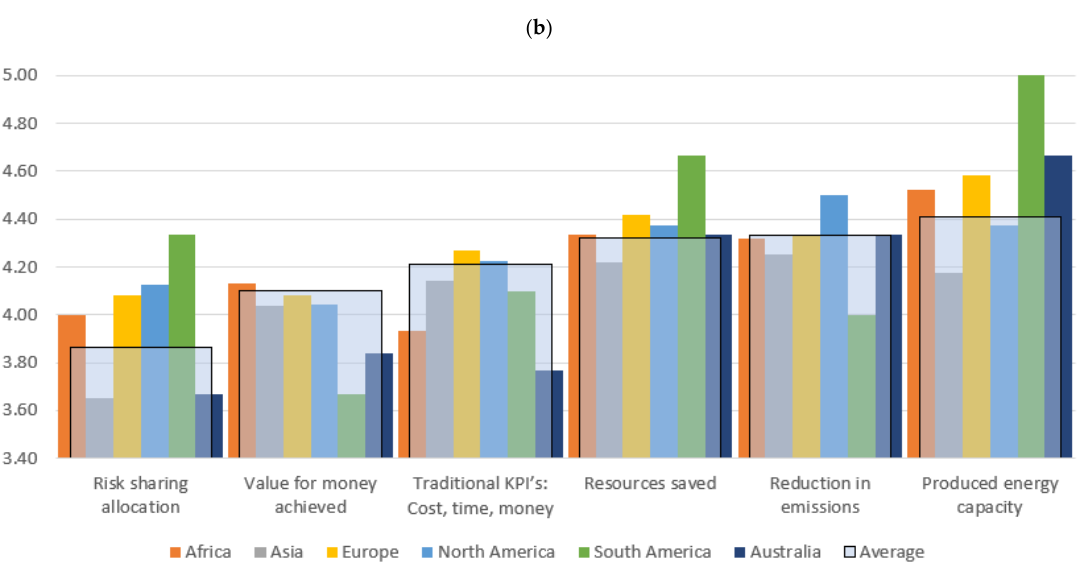
Figure 6. ( a ) Key success factors and ( b ) key success indicators for the success of renewable-energy PPPs across the six continents.